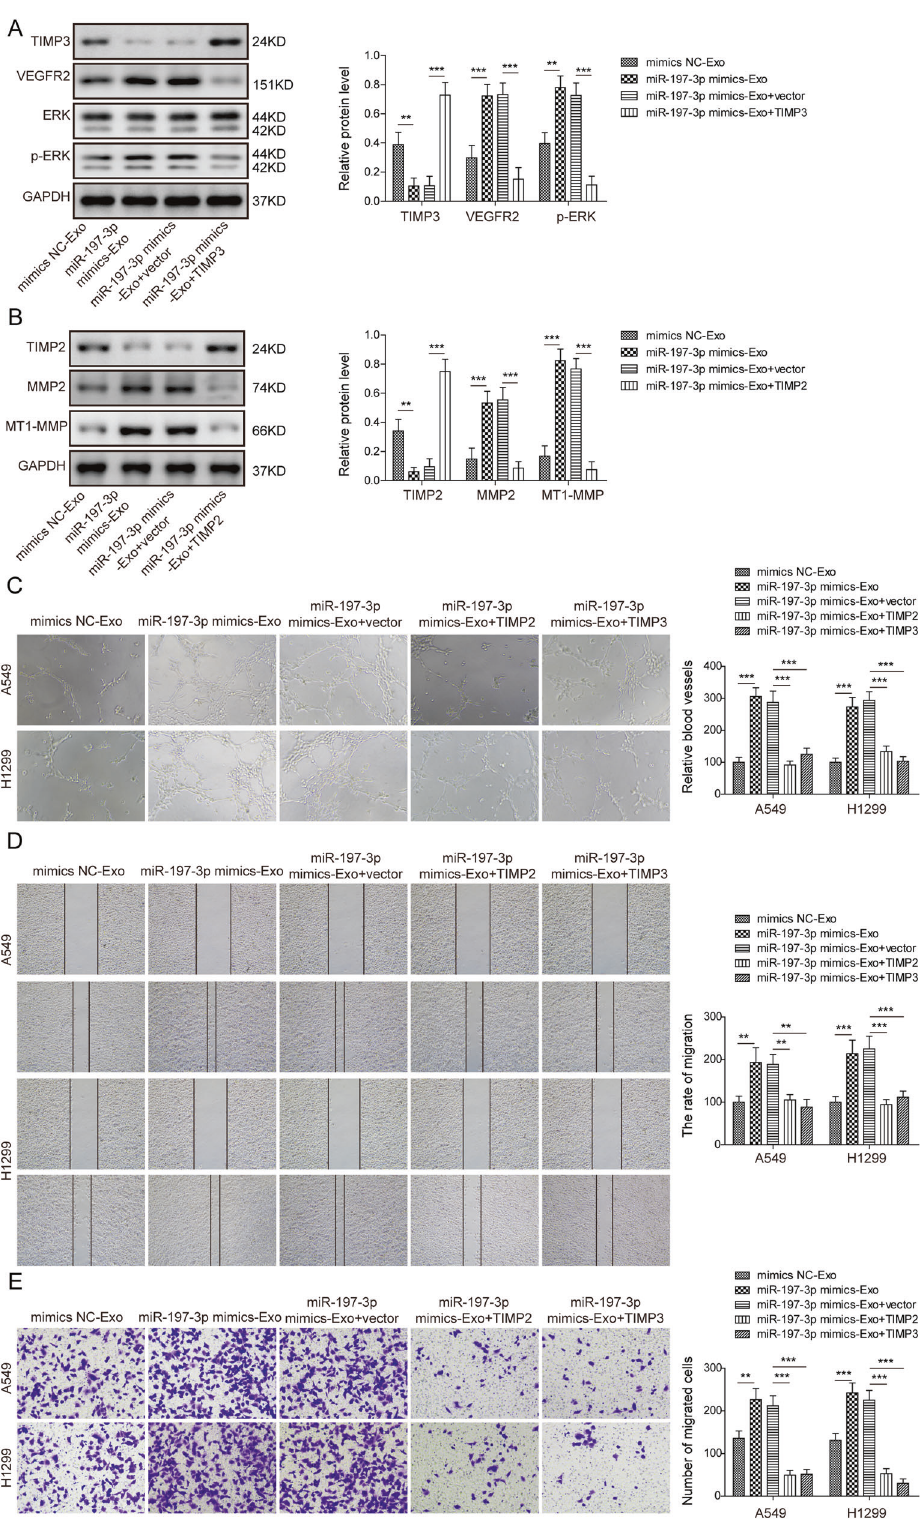
Fig. 7 Exosomal miR-197-3p promotes angiogenesis and migration via silencing TIMP2/3 in HUVECs. A The protein levels of TIMP3, VEGFR2, ERK and p-ERK in different HUVECs were determined by western blot. B The protein levels of TIMP2, MMP2 and MT1-MMP in different HUVECs were determined by western blot. C Angiogenesis was assessed by tube formation assay with quantitative analysis (right panel). D , E Cell migration was assessed by wound healing and transwell assays with quantitative analysis (right panel). Data were representative images or were expressed as the mean ± SD of n = 3 experiments. ** P < 0.01, *** P <